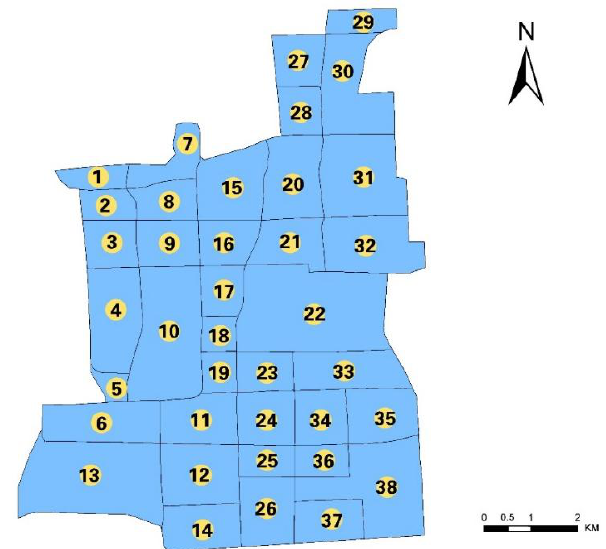
Figure 4. The division of land plots and their corresponding numbers.